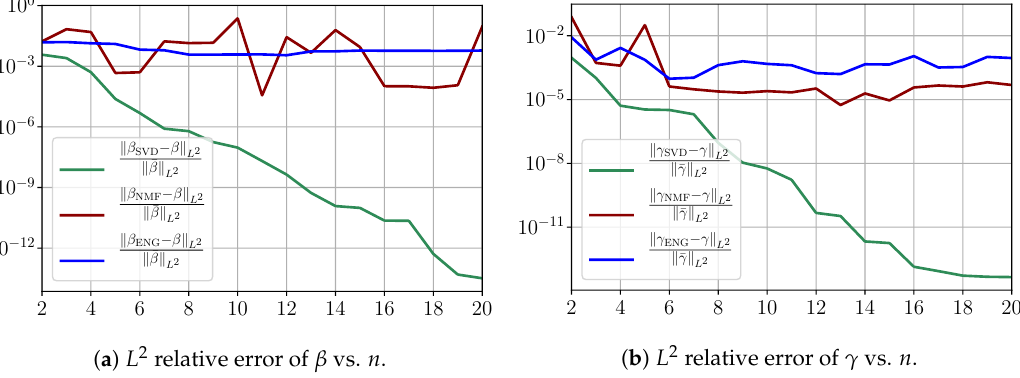
and that belong to the training sets B G